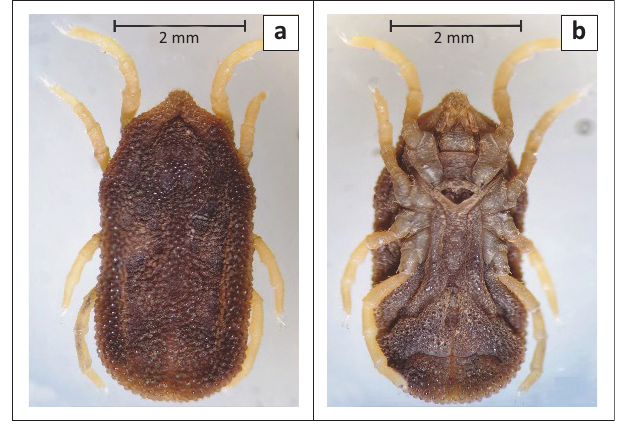
FIGURE 3 : Dorsal and ventral views of adult female Ornithodoros (Pavlovskyella) zumpti